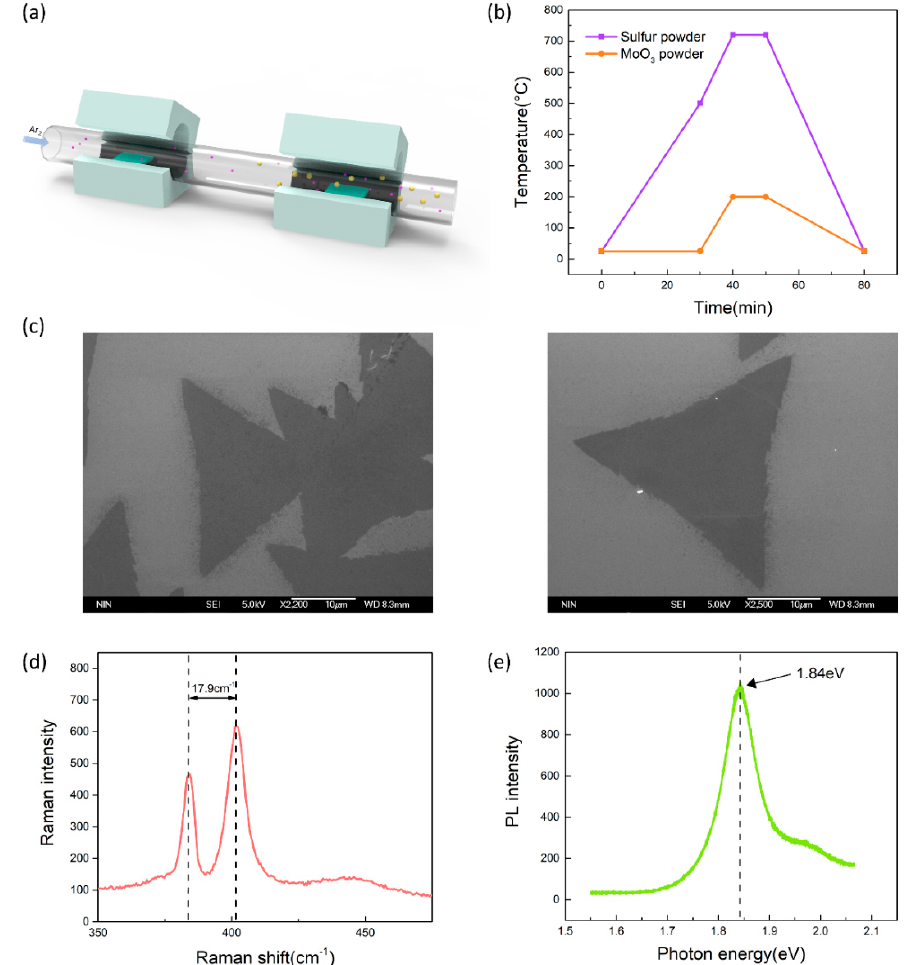
Figure 1. ( a ) The schematic diagram of MoS 2 synthesis by atmospheric pressure chemical vapor deposition (APCVD). ( b ) Detailed temperature control of the growth process. ( c ) A highly uniform monolayer MoS 2 in the scanning electron microscope (SEM). ( d ) The Raman spectrum of the monolayer MoS 2 of two peak positions is 17.9 cm − 1 . ( e ) The PL spectrum of the monolayer MoS 2 with a 1.84 eV bandgap.